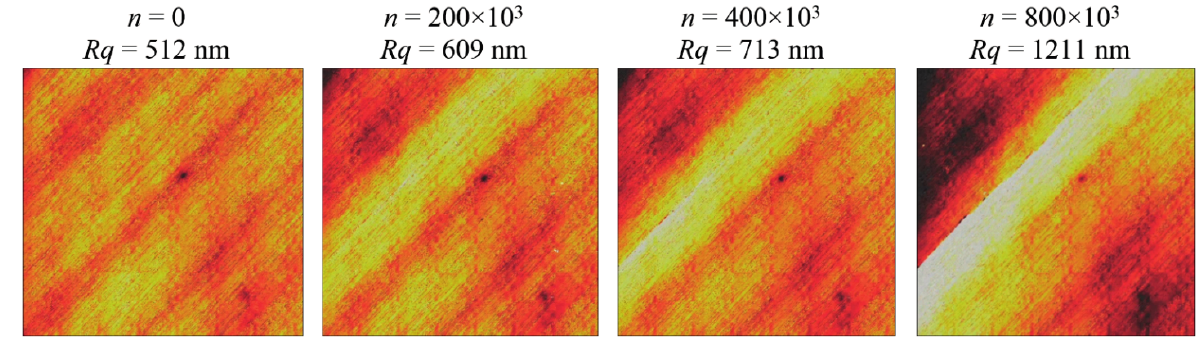
Figure 1. Evolution of the surface topography due to fatigue damage of a CFRP